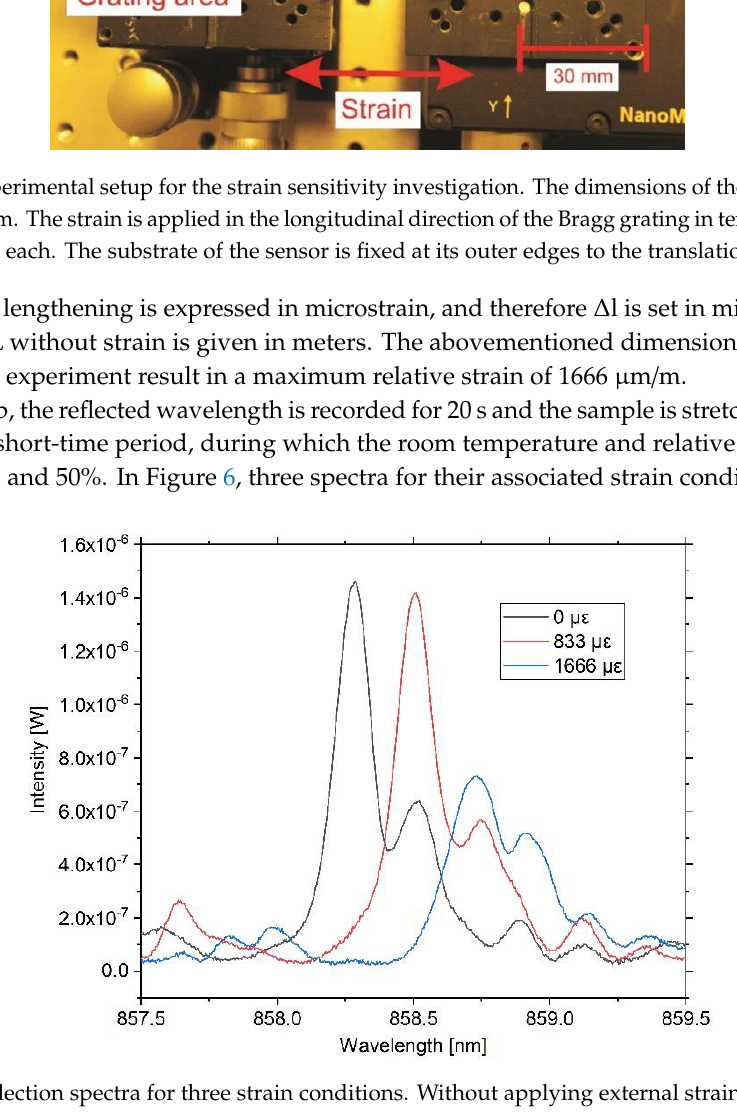
Figure 6. Reflection spectra for three strain conditions. Without applying external strain to the Bragg grating, the center wavelength is 858.285 nm, while for 833 µε the center is 858.509 nm and for a strain of 1666 µε is 858.729 nm. Although in the high strain condition higher attenuation occurs, the peak is evaluated well by the interrogation system. The three spectra are captured with the OSA for qualitative evaluation.